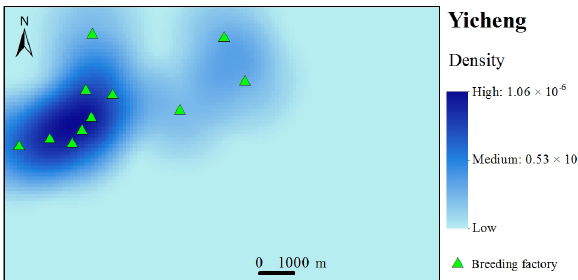
Figure 7. Density map of breeding facilities in the Yicheng area (generated using the Kernel Density spatial analyst tool of the Ar- cGIS software package).